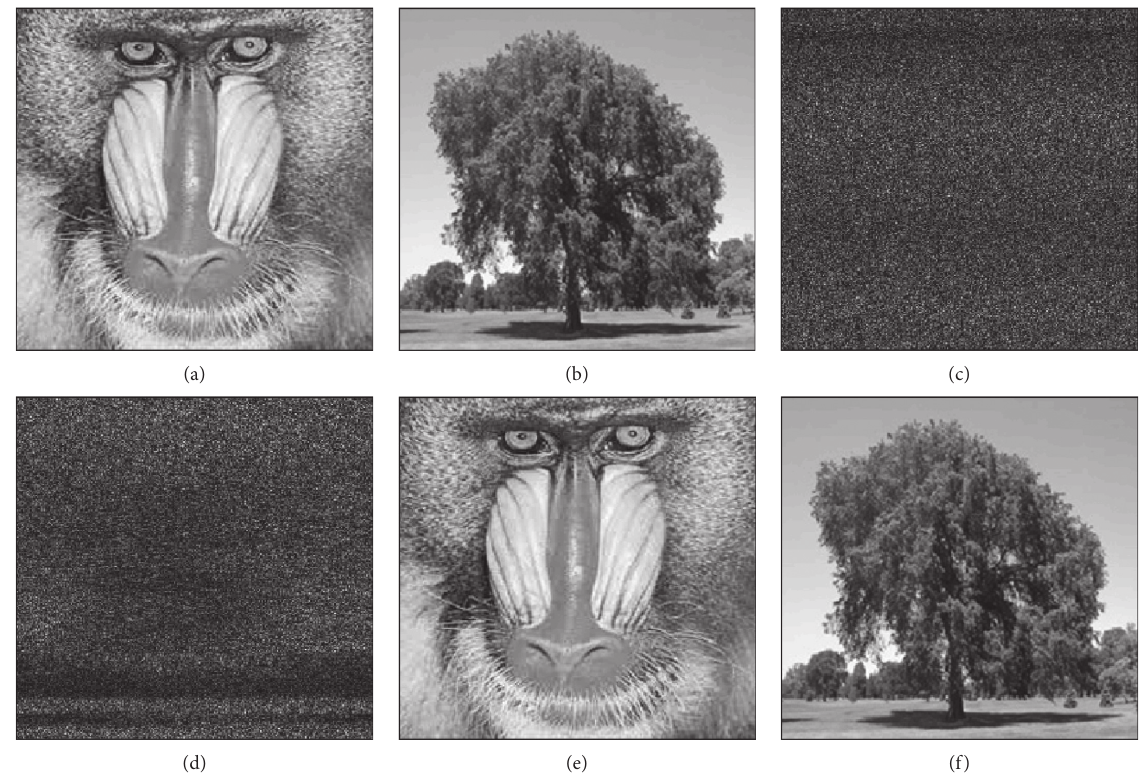
Figure 6: (a, b) Input images of 256 × 256 pixels; (c, d) encrypted images; (e, f) decrypted